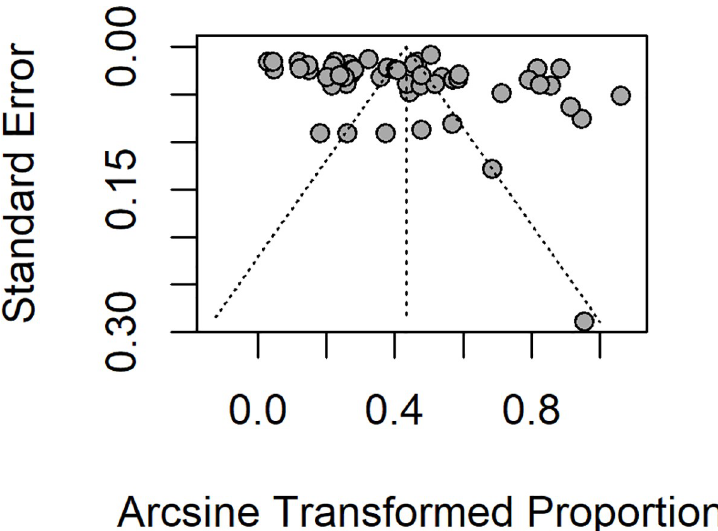
Fig 3. Funnel plot showing distributions of included